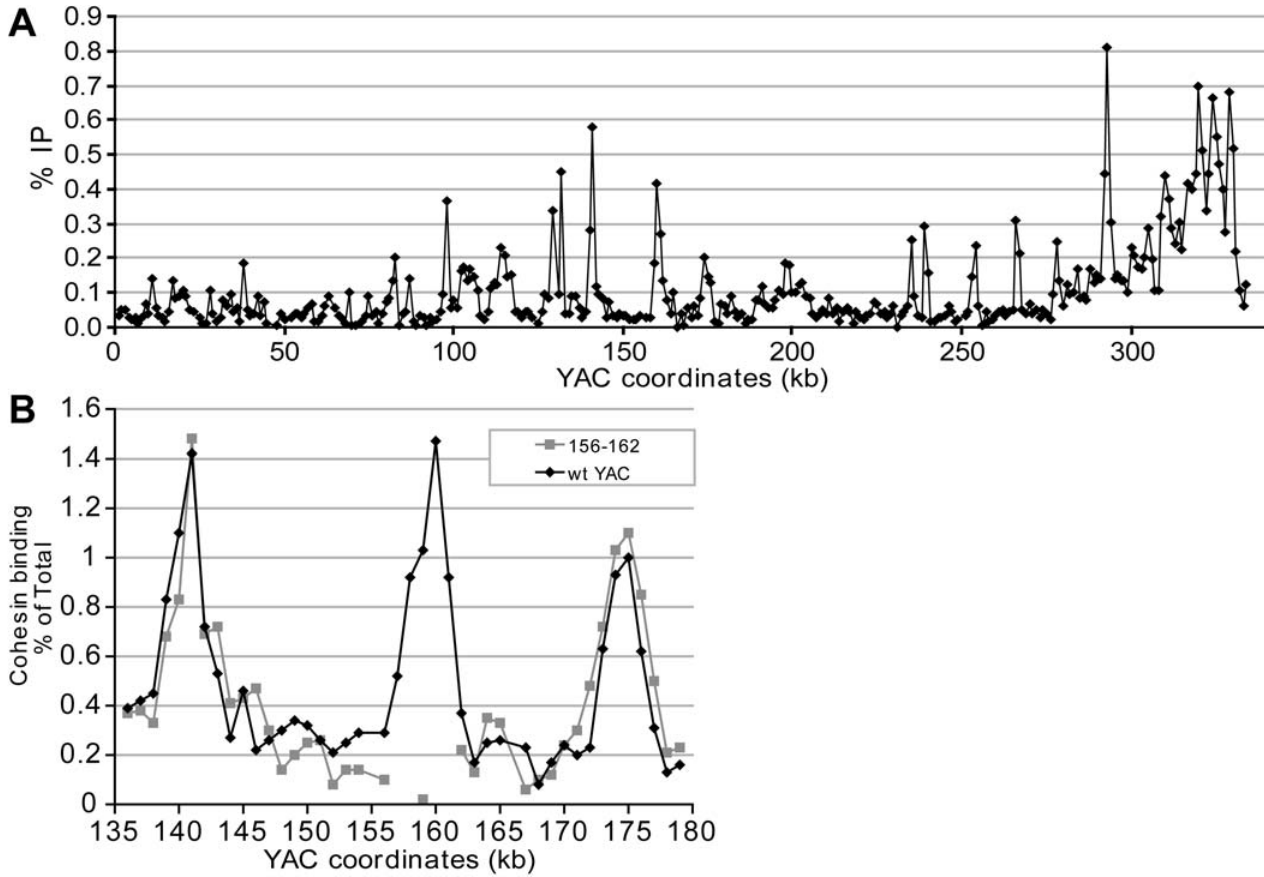
Figure 5. Cohesin Sites Mapped Using ChIP Followed by Semiquantitative PCR with Primers at 1-kb Intervals in a YAC Containing Human DNA (A) Cohesin binding for the entire YAC is shown. (B) Cohesin binding in the region spanning 135–180 kb is shown for the wild-type YAC (black diamonds) and for the YAC containing a replacement of the sequences at 156–162 kb with the gene encoding geneticin resistance (grey squares). DOI: 10.1371/journal.pbio.0020259.g005